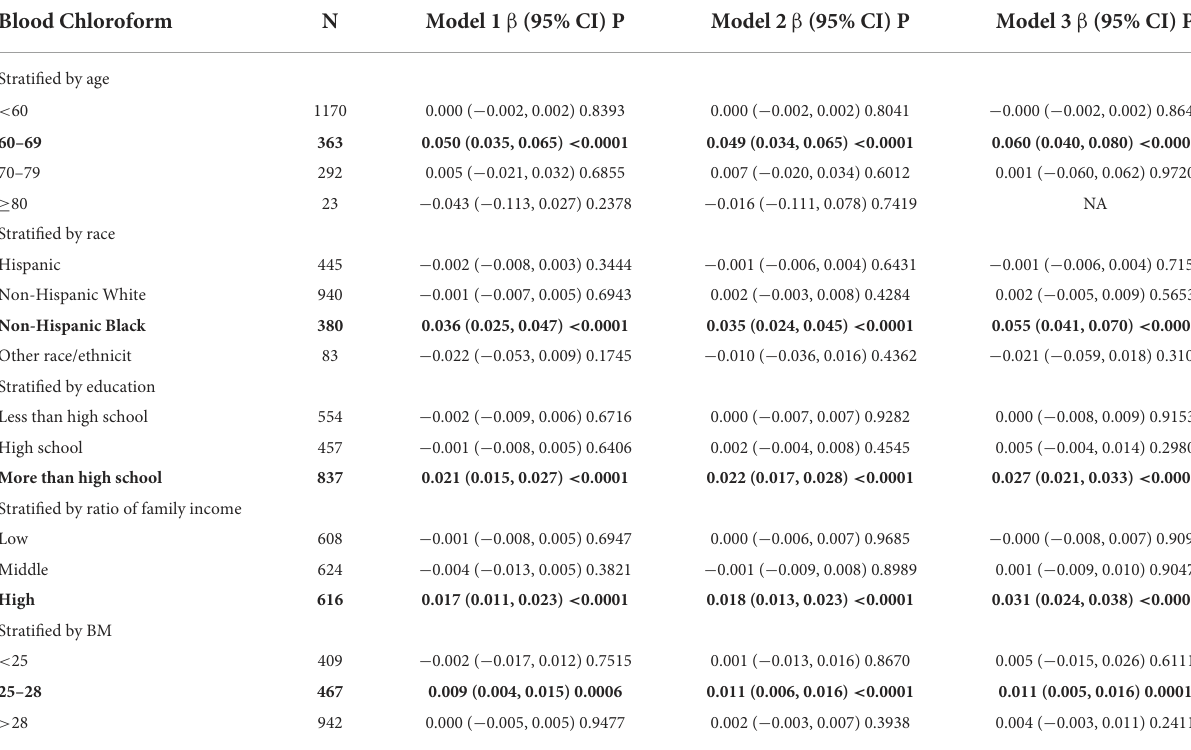
TABLE 3 Stratified associations of blood chloroform on PSA in the prespecified and exploratory subgroup. Blood Chloroform